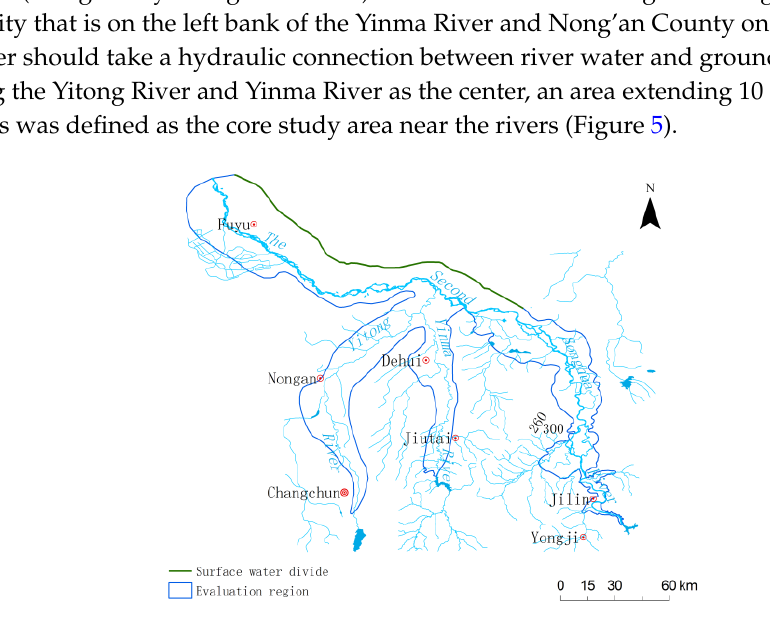
Figure 6. Distribution of hydraulic conductivity. The aquifer thickness distribution in the core study area is shown in Figure 7. In the area traversed by the Second Songhua River downstream of Jilin city and in the reach from the Yinma River estuary to Fuyu City upstream of the Second Songhua River, the aquifer thickness is usually 10 m–30 m, and as much as 50 m in some sections. In the area traversed by the Yinma River, the aquifer thickness of the middle reach from Jiutai to Dehui is 10 m–30 m, whereas the aquifer thickness of other regions is only 5 m–10 m. In the area traversed by the Yitong River, the aquifer thickness of the Changchun City reach and of the Nong’an County reach is relatively thin, but in other locations the thickness is 10 m–30 m.